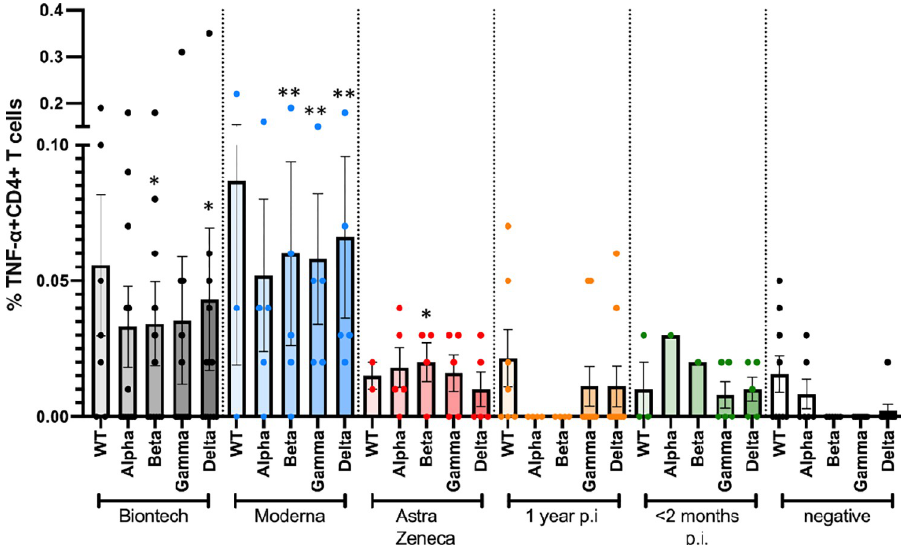
Fig 6. Antigen-specific TNF- α + CD4+ T cell responses to JPT peptide S protein wt and mutant pools. Antigen- specific CD4+ T cell responses elicited by the JPT peptide S protein pools after vaccination with BioNtech (grey), Moderna (blue) or AstraZeneca (red), or one year (orange) or < 2 months (dark green) after naturally occurring infection with SARS-CoV2, or negative controls. The bar graphs show frequencies of TNF- α +CD4+ T cells for wild type, and for alpha (B.1.1.7), beta (B.1.351), gamma (P.1) and delta (B.1.617.2) mutants. The figure shows results of n = 13 independent individuals after vaccination with BioNtech, n = 5 Moderna, n = 5 AstraZeneca, and n = 10 independent individuals one year and n = 7 < 2 months after natural infection with standard errors of the mean (SEM). Samples of non infected individuals tested negative (not shown in the figure to enhance legibility). At least 200,000 events were counted for each individual condition. Significance levels were tested by Kruskal-Wallis test for non-parametric values. � p < 0.05 vs. healthy controls, �� p < 0.01 vs. healthy controls and also p < 0.05 vs. 1 year after